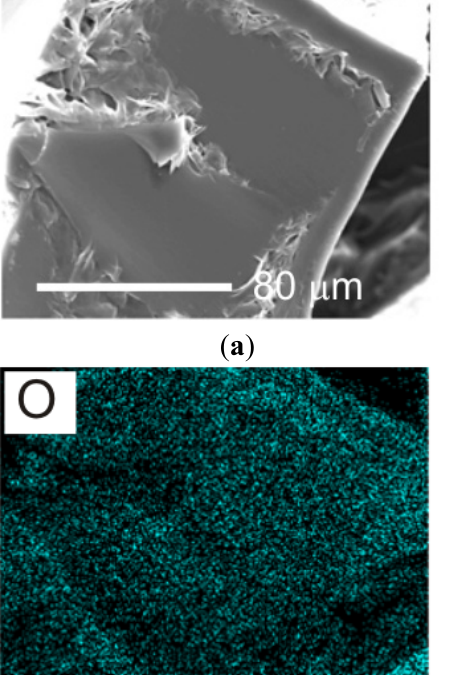
Figure 3. Scanning electron microscopy image of the cross-section of a poly(2-oxazoline)-based gel after grinding and subsequent surface functionalization by ( a ) UV-induced thiol-ene reactions; ( b ) as well as the SEM-EDX images of the cross-section showing the distribution of carbon atoms; ( c ) oxygen atoms; and ( d ) sulfur atoms, respectively. The center plain visible in the images was the interior of the particle prior to cross-sectioning, while all other plains and edges represent the